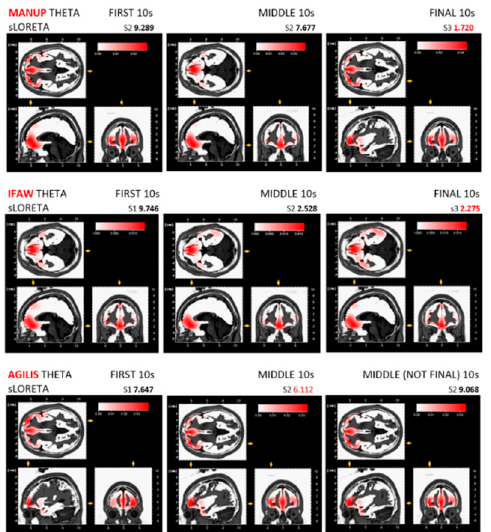
. Figure 5. ManUp, Agilis, and IFAW sLORETA tomographic maps of three highest theta amplitudes from the first, middle, and final 10-s epochs (includes BVA sec times (not ad times) for 10-s epochs). *Agilis shows two sLORETA tomographic maps from the middle 10-s epoch, not final 10-s epoch, as three highest theta amplitudes occurred in the first and middle epochs, not the final epoch. Table 3. Brodmann areas from sLORETA tomographic maps for three highest amplitudes occurring in the first, middle or final 10-s epochs (Appendix A).